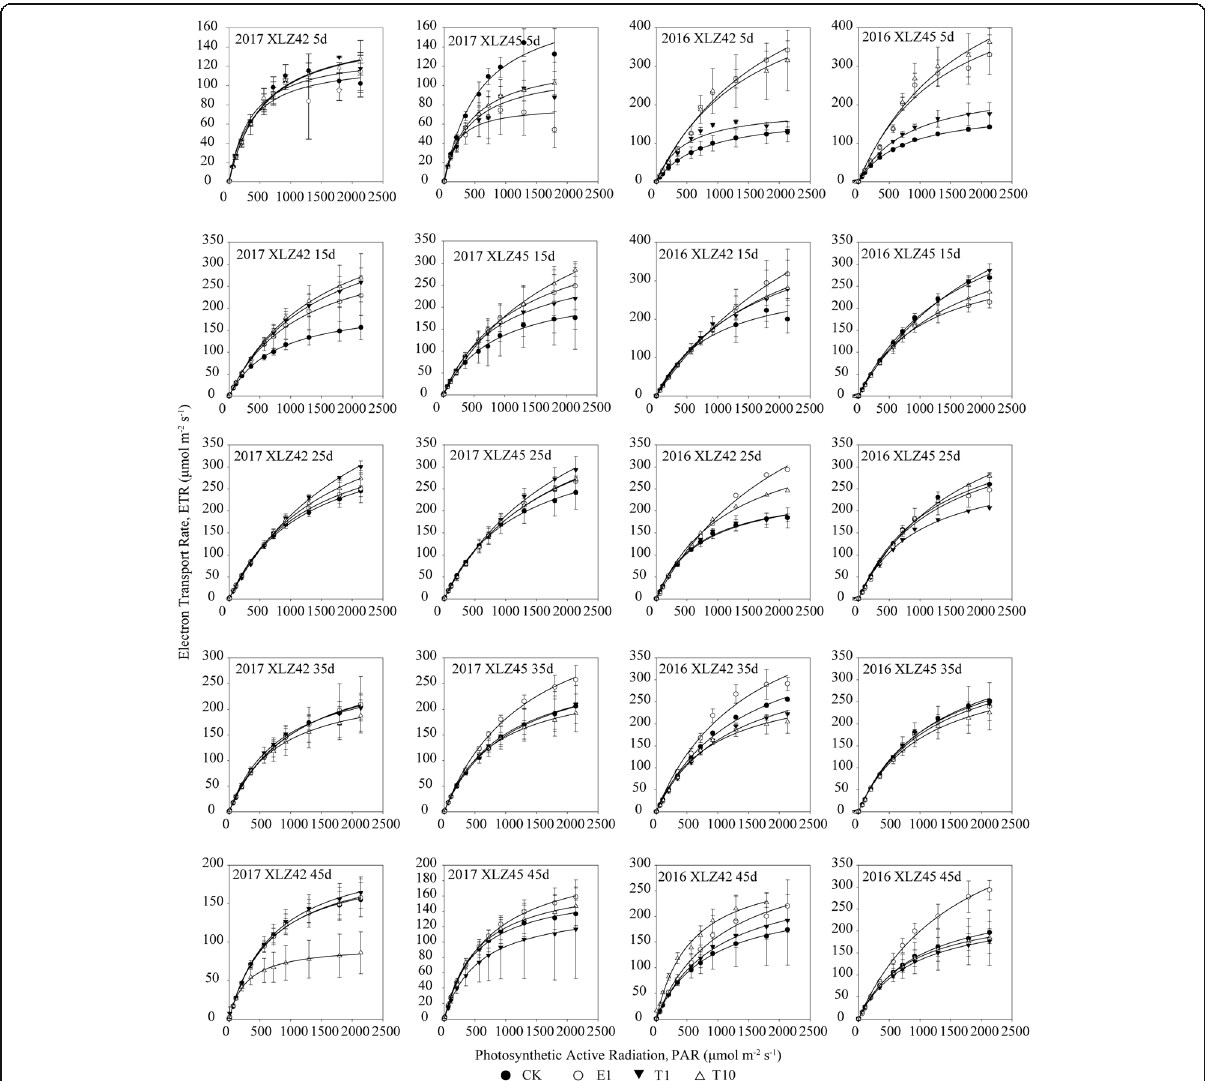
Fig. 9 Rapid light curves of two cotton varieties (XLZ42 and XLZ45) at different days since flowering in various treatment groups: 1 and 10 days before the first irrigation (respectively T1, T10) and 1 day before the second irrigation (E1) after seedling emergence, during 2016 – 2017. The control group (CK) had film mulching throughout the growth stages. Bars are means ± standard deviation (n =